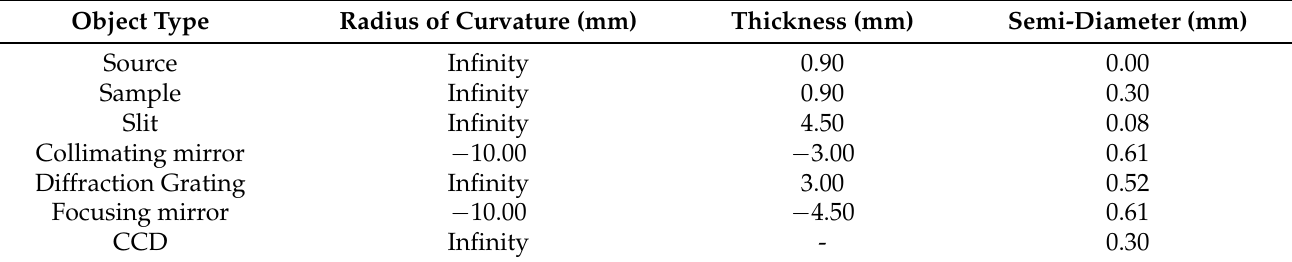
Table 1. Lens data editor window in